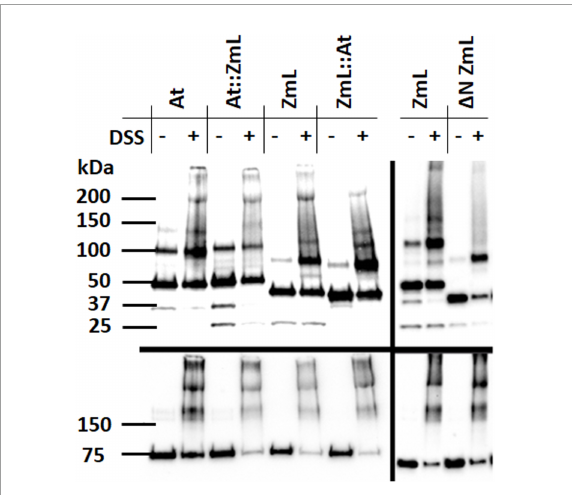
FIGURE10 Influence of the N-terminus on DGAT1